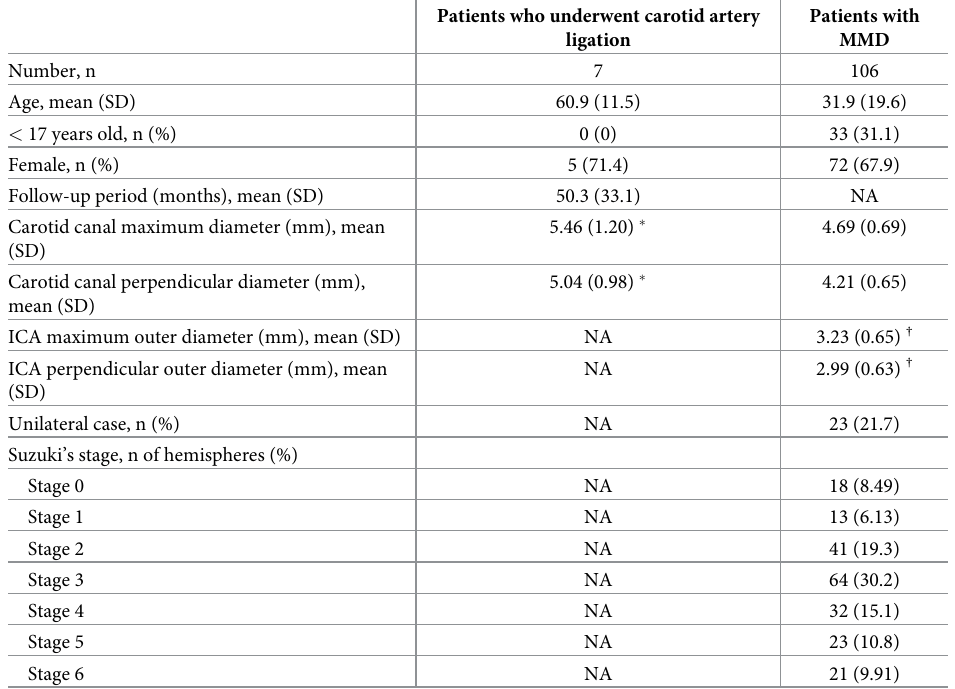
Table 1. Characteristics of the study population.